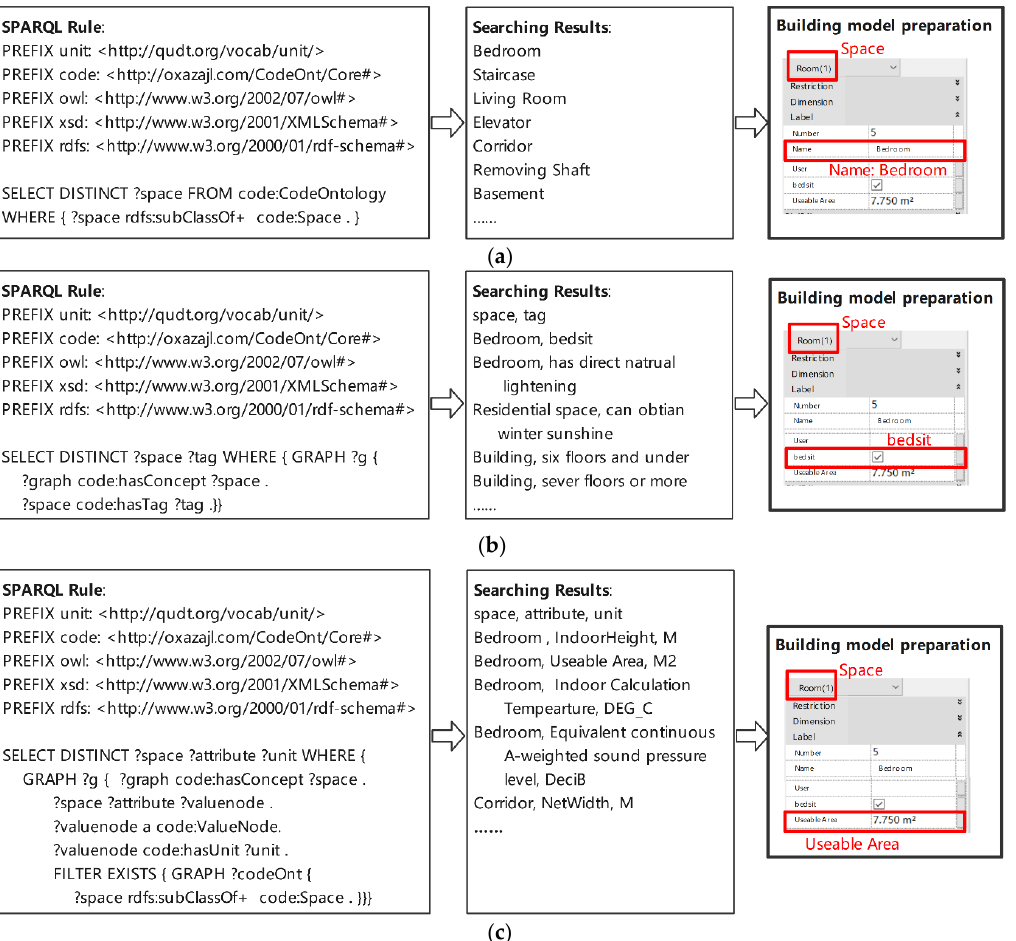
Figure 21. SPARQL queries to retrieve information requirements for building model preparation: ( a ) SPARQL query to retrieve terminologies of space types; ( b ) SPARQL query to retrieve related tags of spaces; ( c ) SPARQL query to retrieve corresponding attributes of spaces.